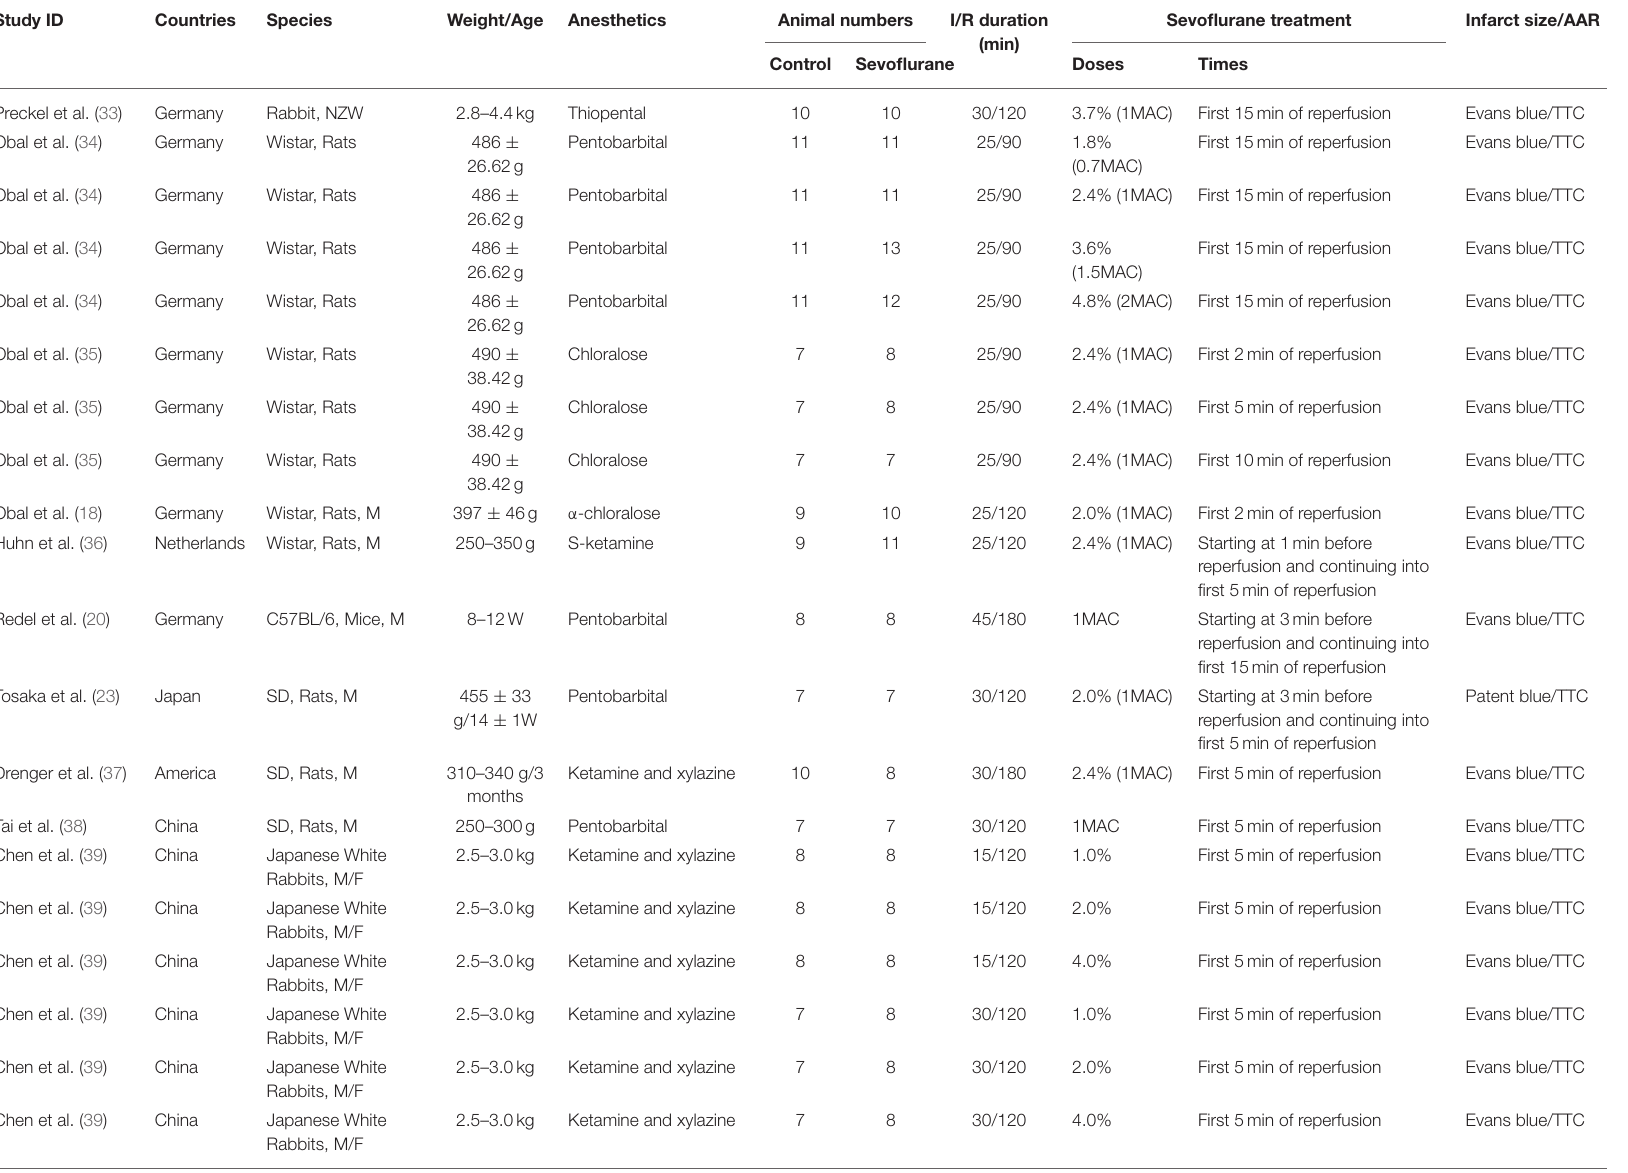
TABLE 1B | The characteristics of sevoflurane postconditioning (SPostC) studies included in the